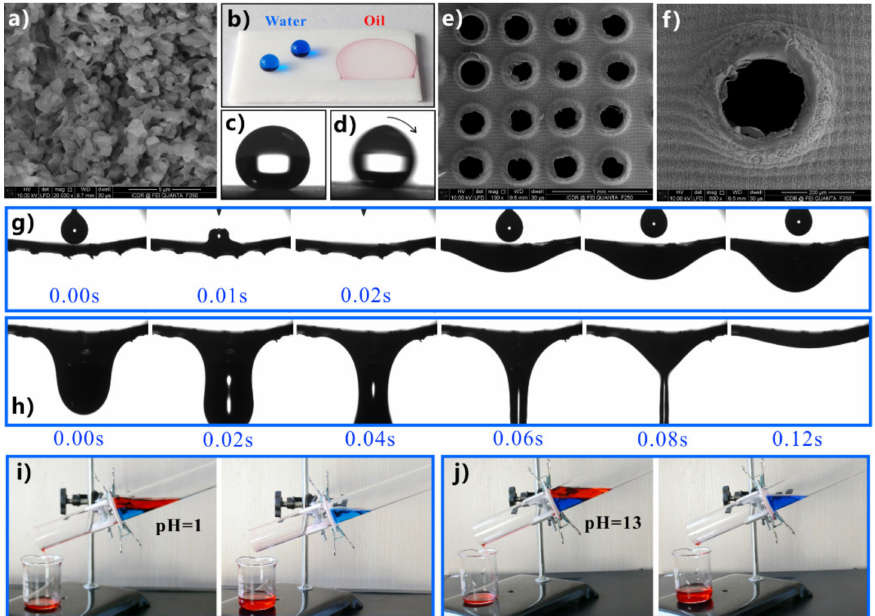
Figure 12. Achievement of oil/water separation by the laser-induced superhydrophobic/superoleophilic porous PTFE sheet. ( a ) Microstructure of the laser-ablated PTFE surface. ( b ) Photo of the drops of water and oil on the structured PTFE surface. ( c ) Static profile and ( d ) rolling snapshot of a small water droplet on the laser-ablated sheet. ( e , f ) Morphology of the structured porous PTFE sheet. ( g ) Oil droplets rapidly permeating through the porous sheet and ( h ) dripping down. ( i ) The separation of the mixture of strong acid solution and oil and ( j ) the separation of the mixture of strong alkaline solution and oil by the porous, rough PTFE sheet. Water was dyed blue, and oil was dyed red. Reprinted with permission from ref. [241]. Copyright 2019,